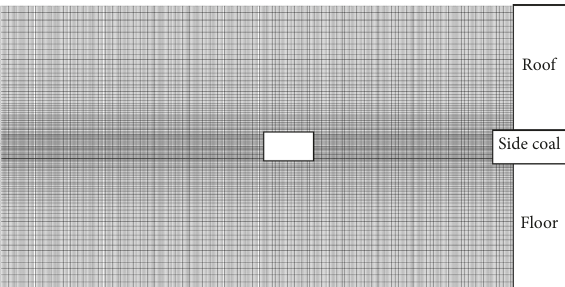
Figure 2: Numerical model.